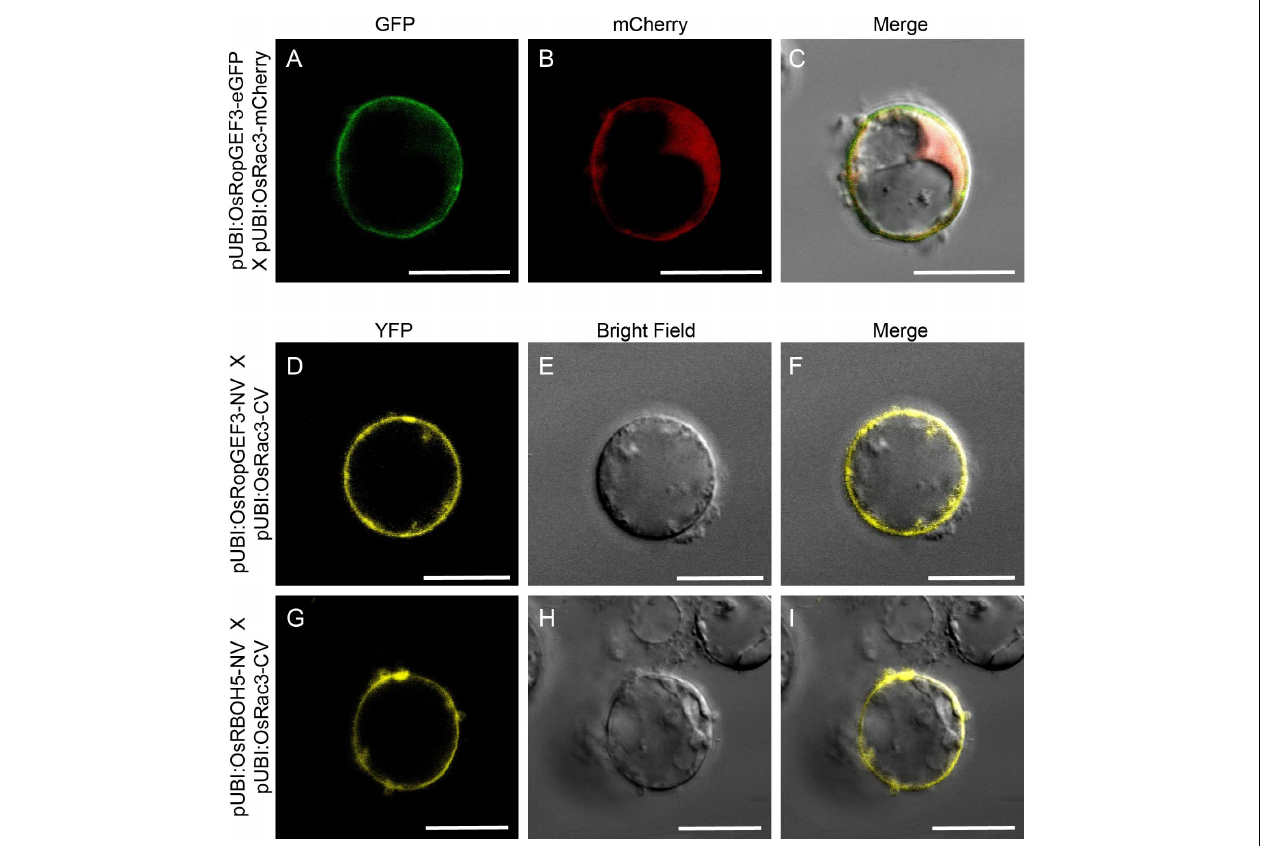
FIGURE 7 | Colocalization and BiFC visualization in rice root protoplasts. (A–C) Subcellular localization of OsRopGEF3 and OsRac3. The complete ORF OsRopGEF3 was combined with eGFP, whereas that of OsRac3 was combined with mCherry. These constructs were coexpressed in root protoplasts. (D–F) Fill-length OsRopGEF3 and OsRac3 proteins were individually fused with the N- and C-terminals of Venus protein. (G–I) The N-terminal protein region of OsRBOH5 was fused with the N-terminal of Venus protein and cotransfected with OsRac3-CV. Each construct was expressed using a maize Ubi (ZmUbi) promoter. The protoplasts were observed under a laser scanning confocal microscope. Bars = 10 µ